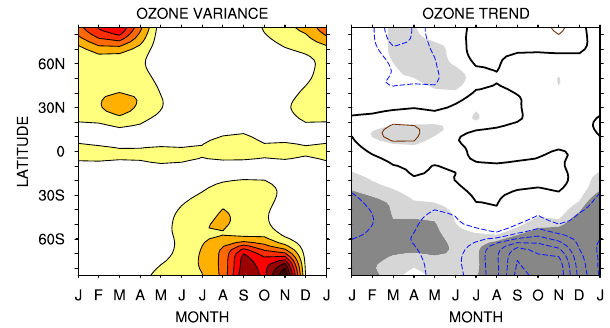
Fig. 5. Annual cycle of the ozone sample variance and trend. The variances and trends are calculated over the 1980–2001 period based on monthly mean ozone averaged between 100 and 20hPa. Dashed blue (solid brown) lines represent negative (positive) values; the bold solid line represents the zero-line. Light grey (dark grey) shading represents the 90% (99%) statistical significance level of the trends. Contour spacing is 0.05ppmv 2 for the ozone variance and 0.1ppmv per decade for the ozone